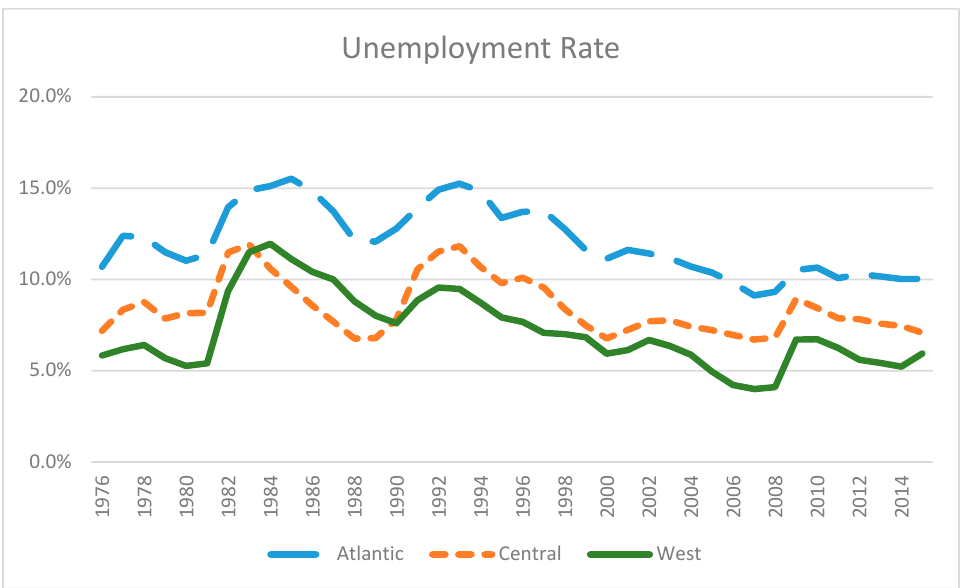
Figure 1. Unemployment Rates by Canadian Region 1976–2015. Source: Statistics Canada. Table 282-0002—Labour force survey estimates (LFS).